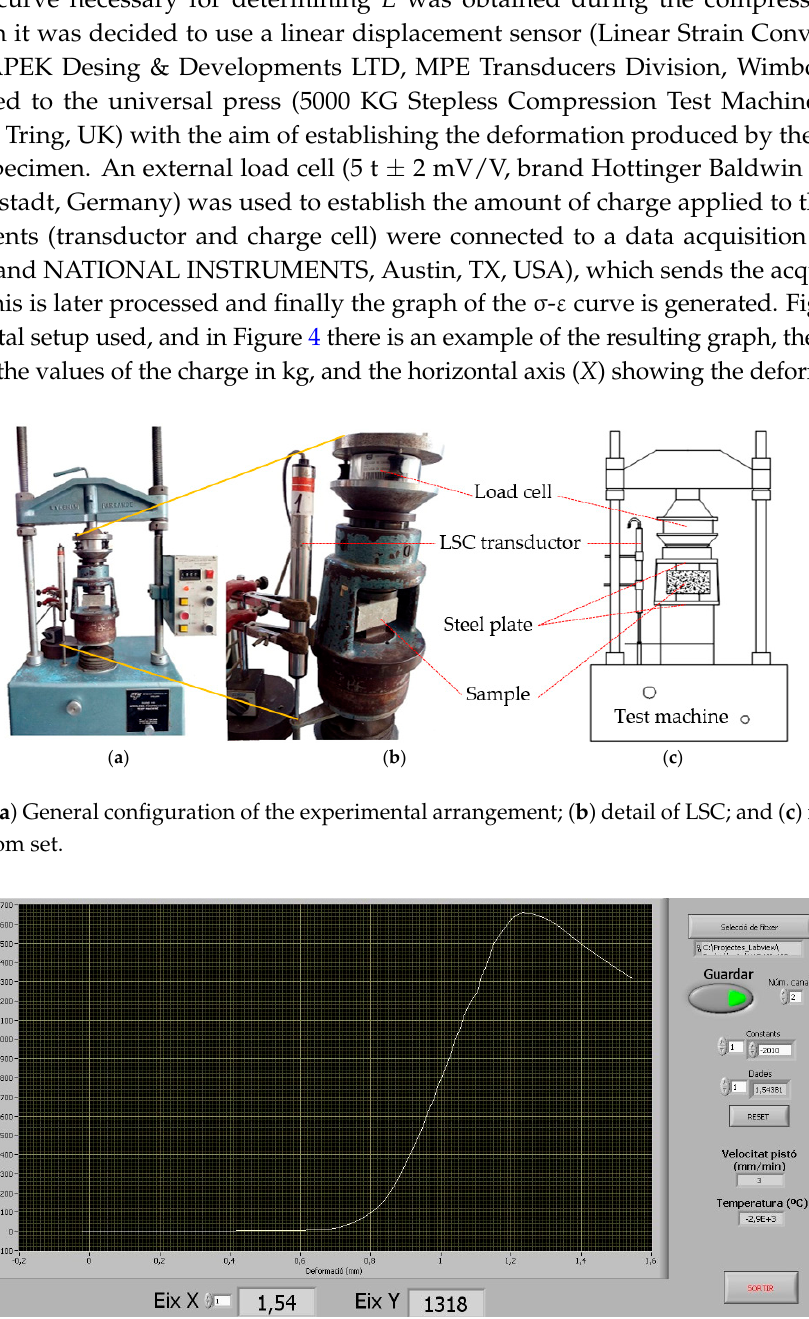
Figure 4. Curve σ - ε resulting from a test.